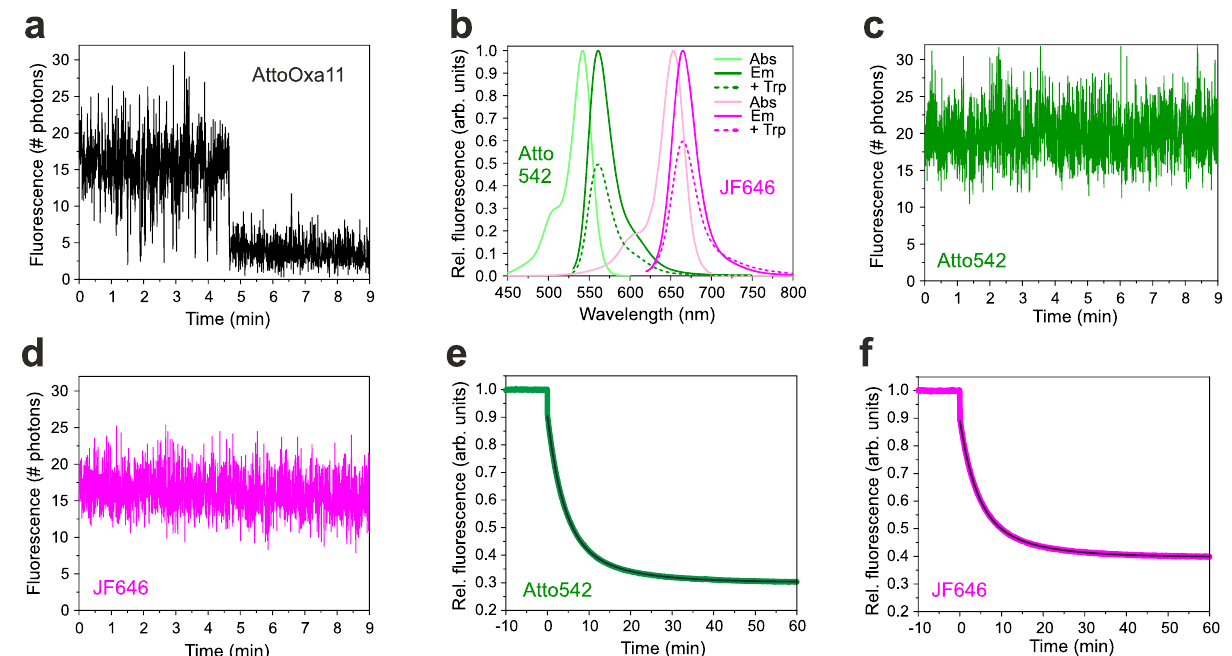
Fig. 3 Selection of fl uorophores for two-colour smPET fl uorescence microscopy. a Sm fl uorescence intensity time traces of an AttoOxa11-Hsp90 conjugate immobilized on a glass surface, recorded under nucleotide-free conditions in oxygen-depleted solution. Data were measured using an integration time of 0.3 s per frame at a laser excitation energy of 10 W/cm 2 . b Absorption (Abs) and fl uorescence emission (Em) spectra of Atto542 and JF646 (solid lines). Emission spectra recorded in presence of 25 mM Trp are shown as dashed lines. c , d Sm fl uorescence intensity time traces of Atto542-Hsp90 and JF646-Hsp90 conjugates immobilized on a glass surface, recorded under nucleotide-free conditions in oxygen-depleted solution. Fluorescence emission intensities were measured using an integration time of 0.3 s per frame at a laser excitation energy of 10 W/cm 2 . e , f Bulk fl uorescence intensities recorded from Atto542 and JF646 involved in a PET fl uorescence reporter for NM-association of Hsp90 (modi fi ed mutant E192C-N298W), respectively. Measurements were carried out in cuvette experiments using a benchtop fl uorimeter. 4 mM AMP-PNP was added at t = 0 min. Black lines are bi- exponential fi ts to the data. Source data are provided as a Source Data fi